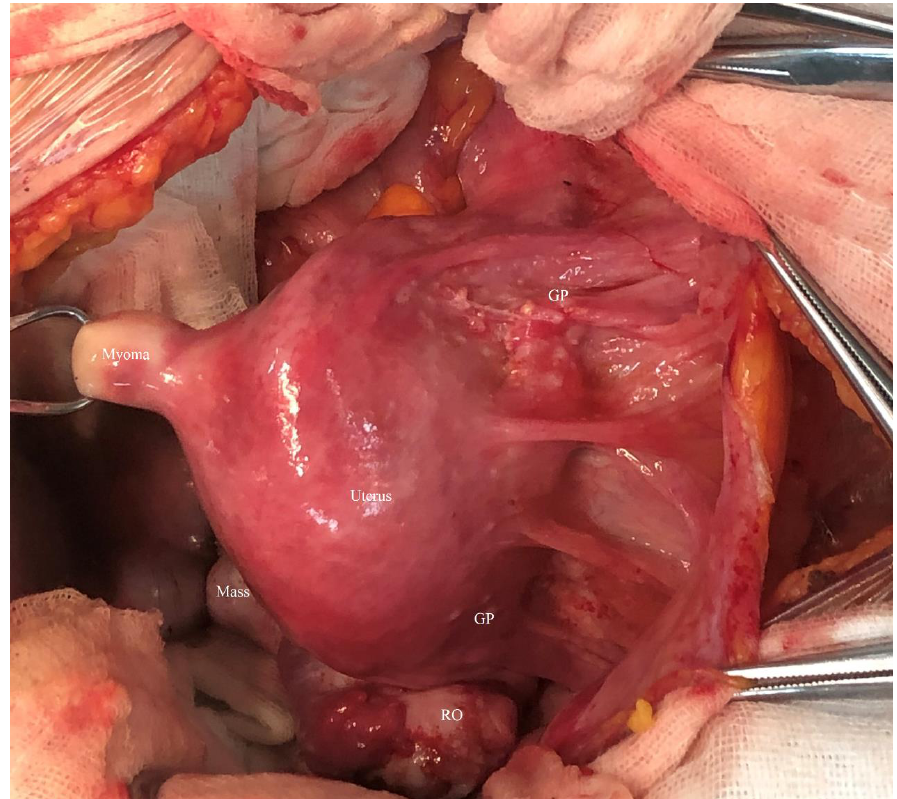
Figure 4. Intraoperative views during exploratory laparotomy demonstrated a small myoma located at the posterior uterine wall, and multiple glial tissue (“GP”) seeding was noted at the uterine surface, vesical peritoneal reflection. The mass was located in the pouch of Douglas, with most proportion obscured by the uterus (RO, right ovary).